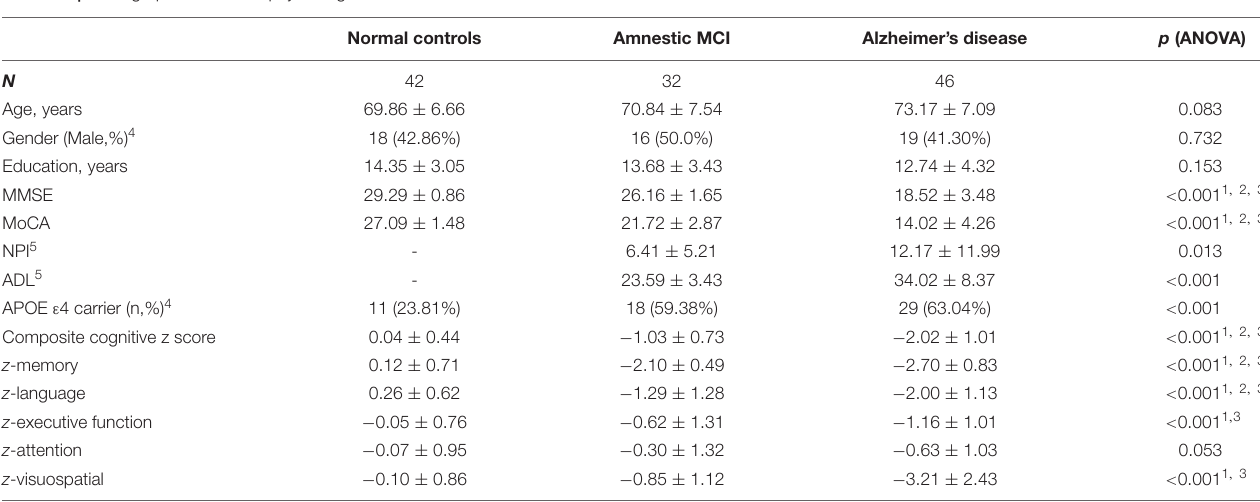
TABLE 1 | Demographic and neuropsychological